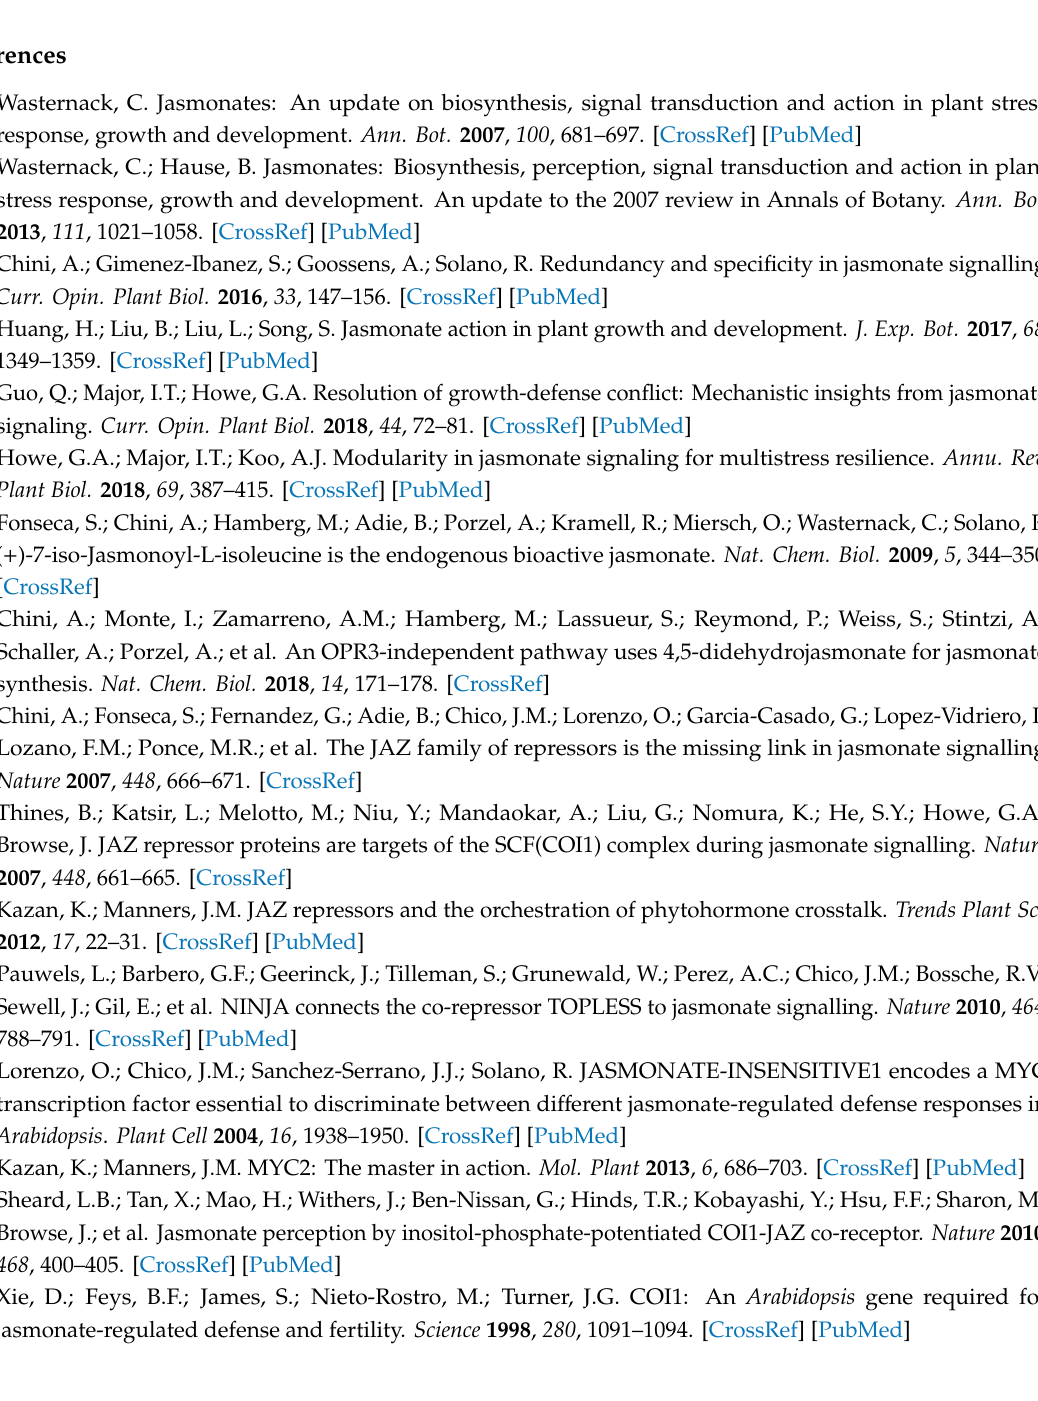
Table S2: The primers used in this